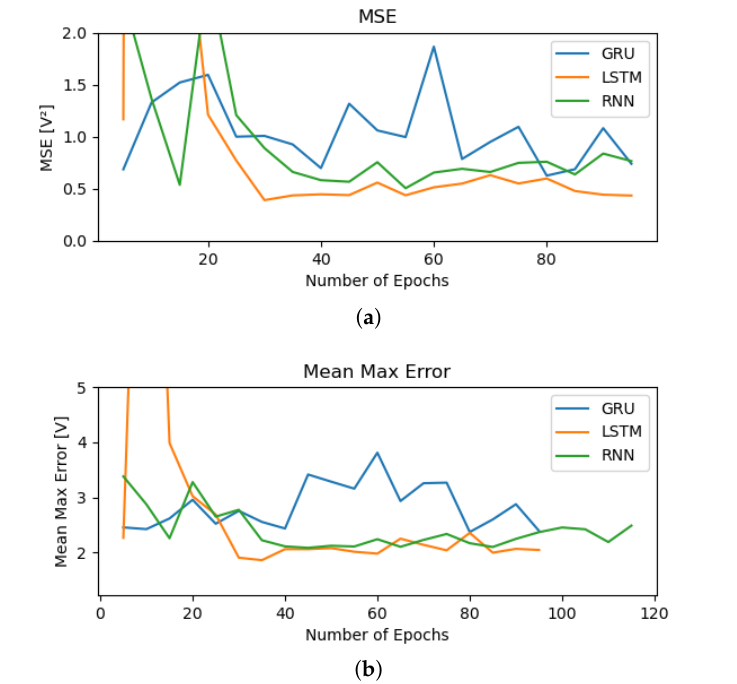
Figure 5. Training progress indicated by the MSE ( a ) and Mean Max Error ( b ) of GRU, LSTM and RNN architectures, based on validation of the test